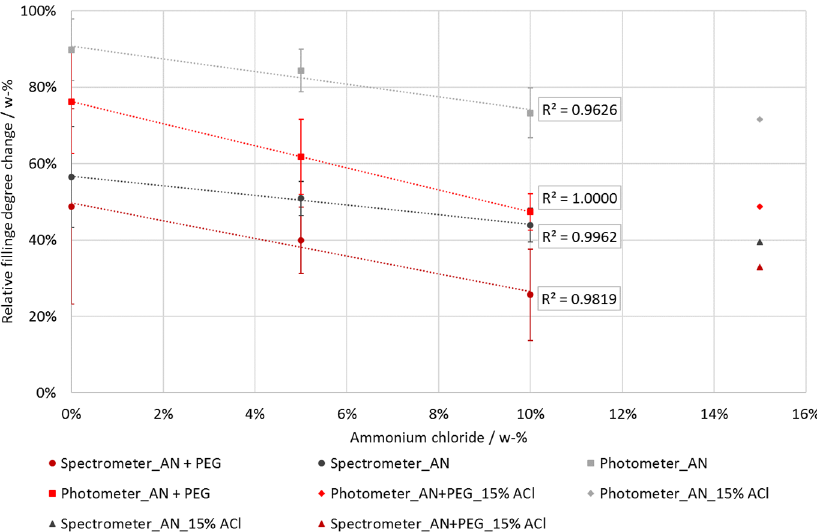
Figure 7. Summary of all performed experiments. The relative change in filling degree versus the ammonium chloride concentration of the outer water phase is plotted. For the concentration range 0% to 10%, linear trend lines are also present, all with a Pearson coefficient of at least R = 0.9626. At 15% ammonium chloride in the external water phase, the linear trends are interrupted, which is why they are plotted separately. Table 2. Comparison of the osmolality difference and relative filling degree change for each investigated double emulsion. AN: ammonium nitrate. ACL: ammonium chloride. PEG: Polyethylene